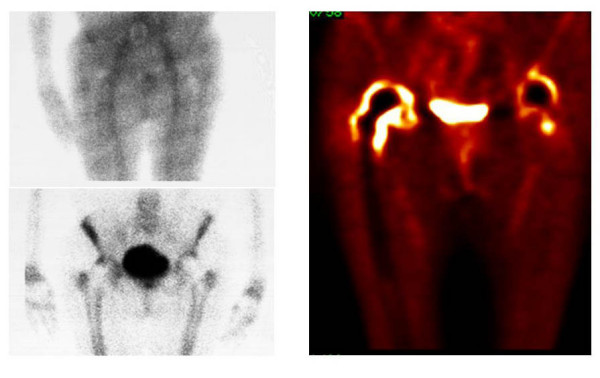
In a case with extensive abrasion-induced inflammation on the right hip prosthesis (bacterial infection was excluded) whereas bone scan in comparison to 18F-FDG-PET does not adequately demonstrate the pathology. The PET examination shows broad periprosthetic uptake as expression of synovitis.